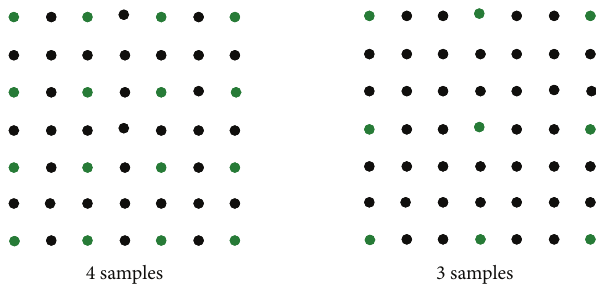
Figure 15: Taking samples in a